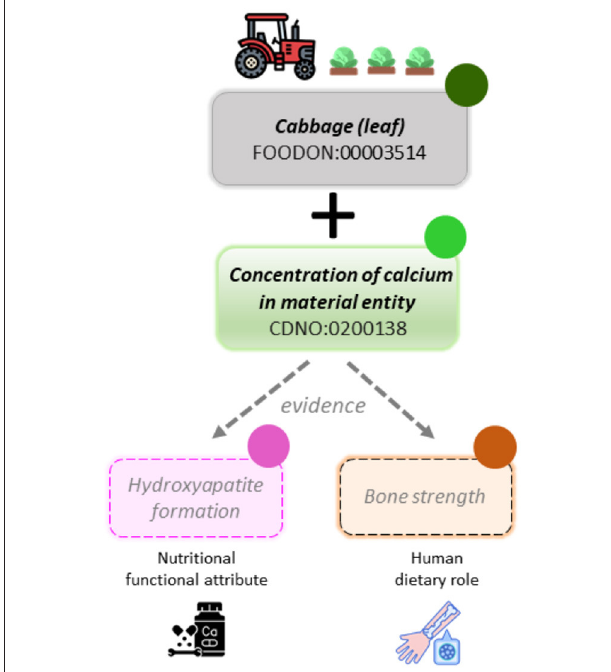
FIGURE 2 | Vocabularies for annotating the food to health continuum. Schematic of proposed workflows using ontology classes to associate component concentration with independent concepts of nutritional attribute and dietary role. In data curation, each assignment requires identification of supporting evidence. Adoption of common vocabularies in diverse data repositories would facilitate data mining and inference. The FoodOn organismal source (olive solid circle) is used to filter available datasets, alongside the nutritional component terms (green solid circle). The structured vocabulary and definitions within the ‘ nutritional functional attribute’ class (pink solid circle) and the ‘ human dietary role’ class (orange solid circle), will then be available to represent concepts associated with one or more nutritional components, where a domain specialist has identified sufficient supporting evidence. These terms may be mapped and reused from existing OBO ontologies such as: the Experimental Factor Ontology (EFO) ( 42), the Human Phenotype Ontology (HP) ( 43), the Ontology for Biomedical Investigations (OBI) and the Ontology of Biological Attributes (OBA) (